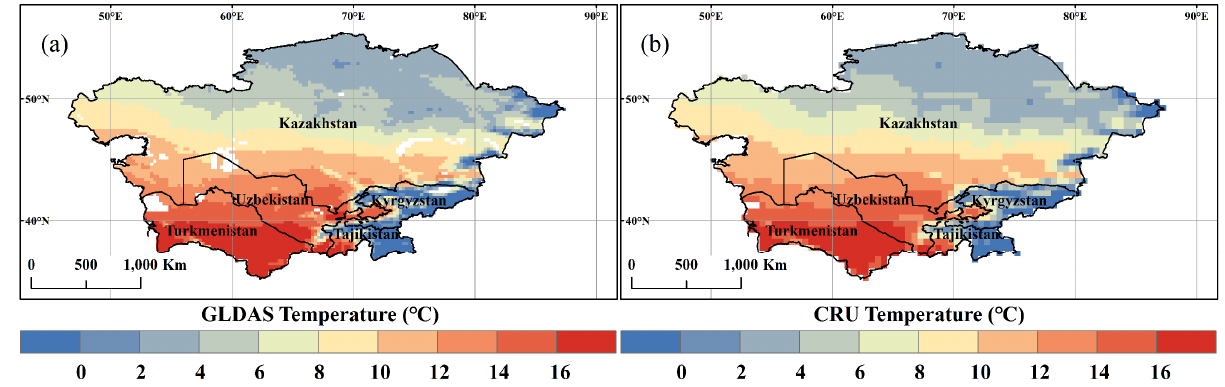
Figure 2. Spatial distribution of the annual means for ( a ) GLDAS temperature, ( b ) CRU temperature over the GLRCA from 1982–2014.